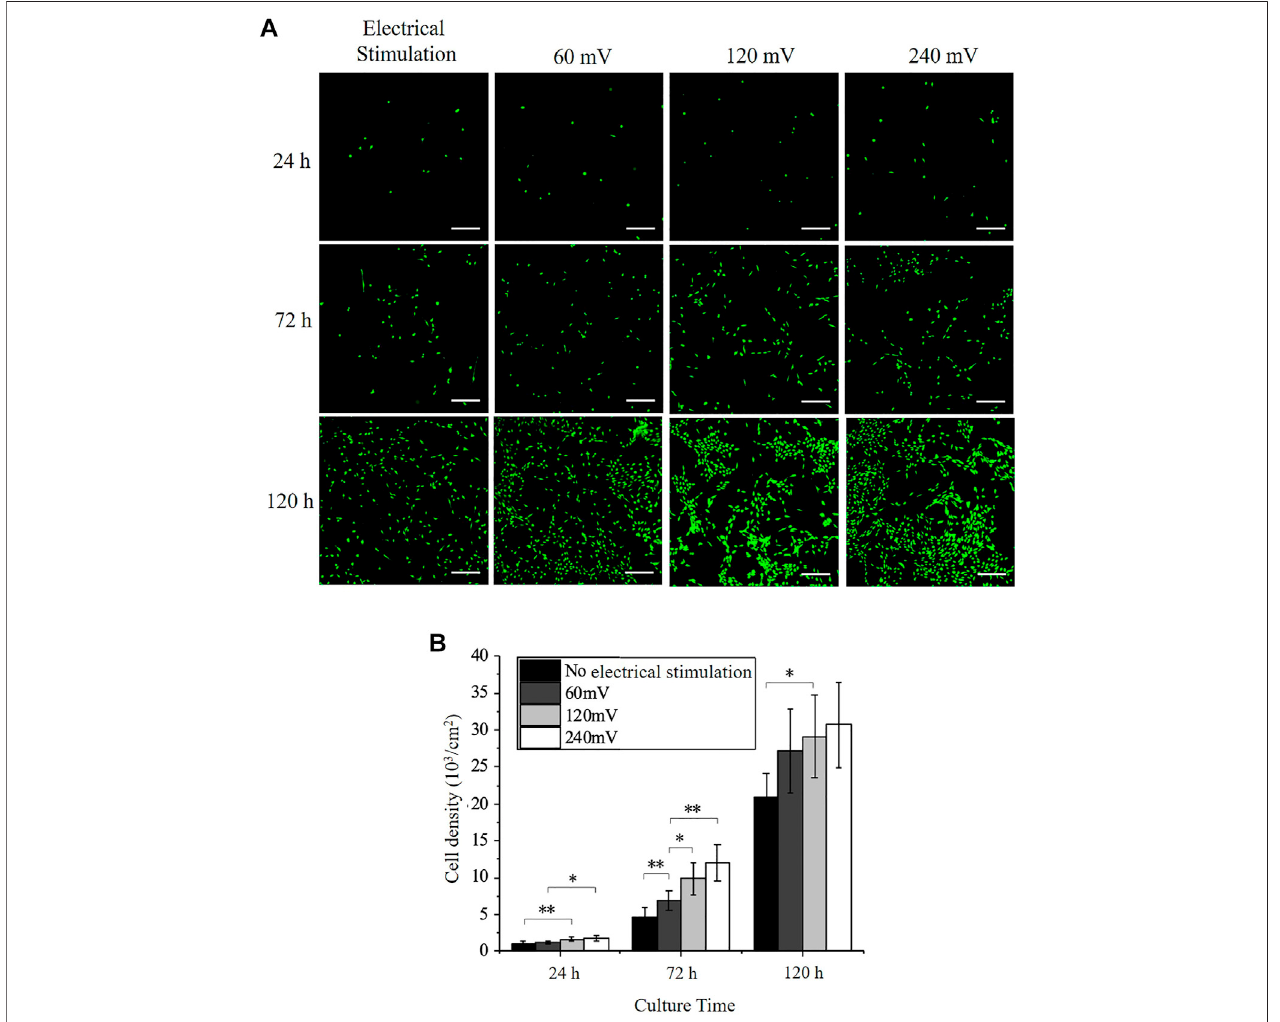
FIGURE3| PC12Immuno fl uorescencestainingandcellproliferationunderelectricalstimulation. (A) Immuno fl uorescenceimagesofPC12cellsculturedwithoutor with electrical stimulation. Scale bar: 200 μ m. (B) Cell densities of PC12 cultured on the electrodes. The signi fi cant difference between all the groups is indicated ( p , p < 0.05; pp , p < 0.01; n > 10